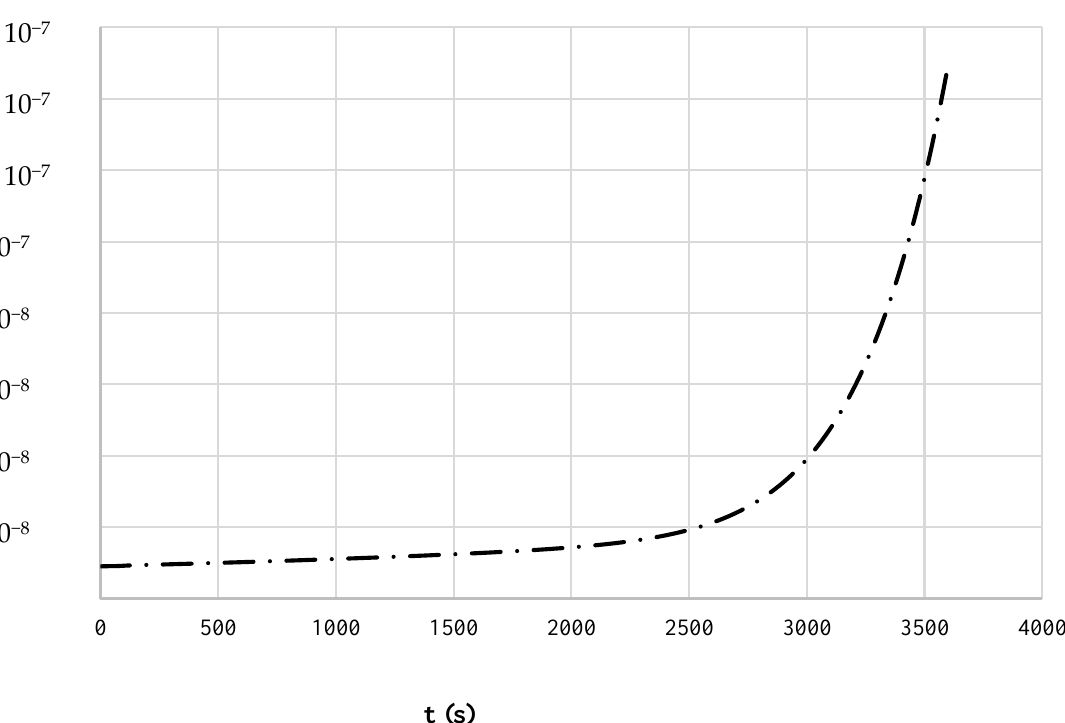
Figure 6. Water mole fraction in the output stream in natural gas with time.